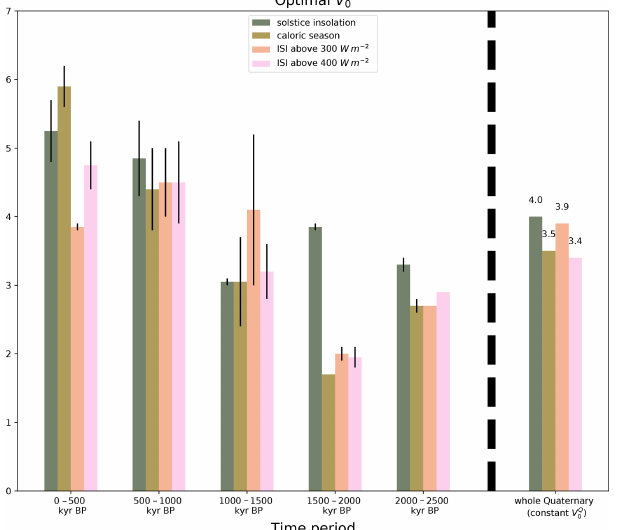
Figure 2. Optimal deglaciation threshold V 0 over the five 500kyr periods for the four different summer insolation forcings at 65 ◦ N and optimal constant V 0 threshold obtained when the optimization procedure is done over the whole Quaternary ( V Q values of the deglaciation threshold V 0 maximize the accuracy cri- teria, the mean value is plotted and the other possible values are represented with error bars.